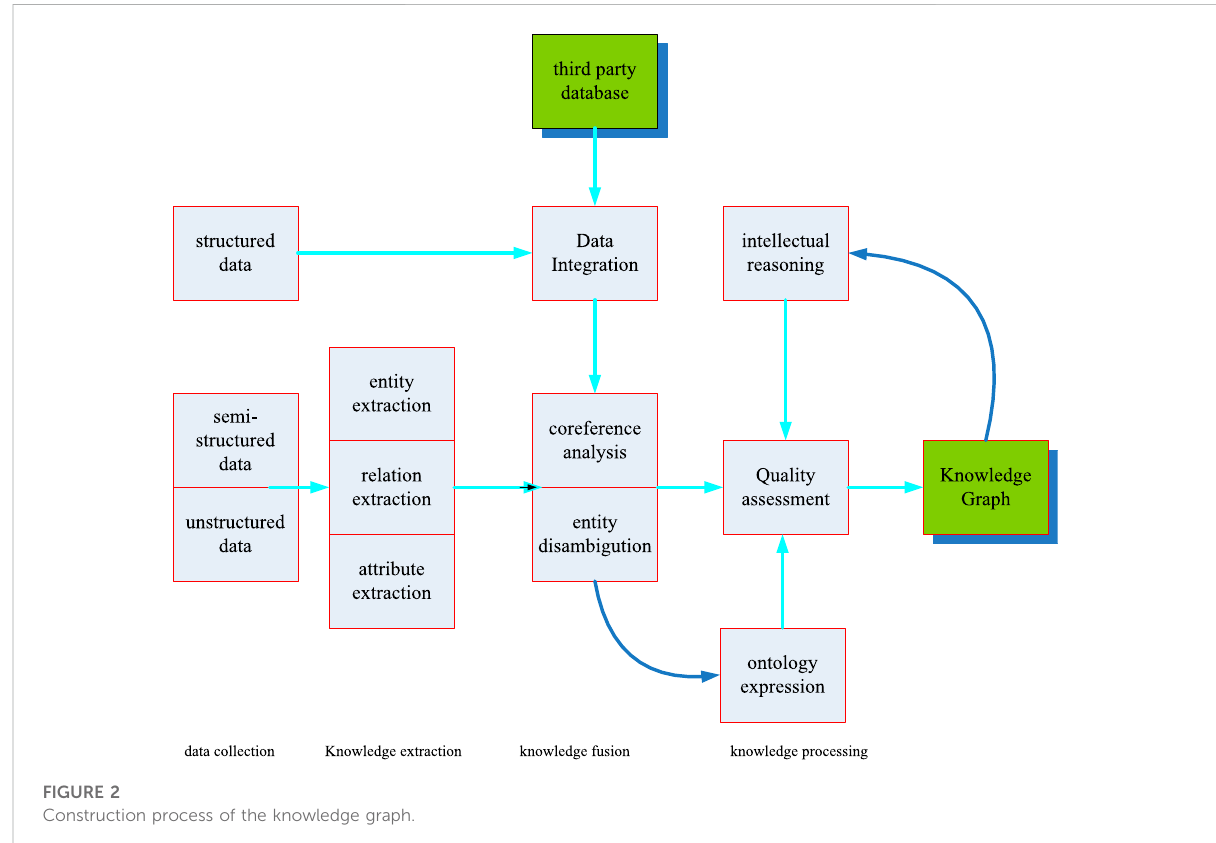
FIGURE 2 Construction process of the knowledge graph.